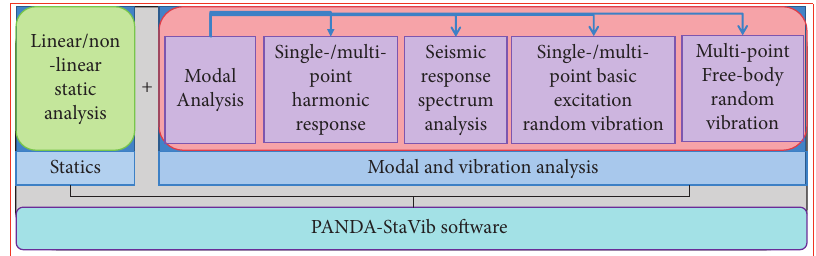
Figure 4: Analysis modules in PANDA-StaVib